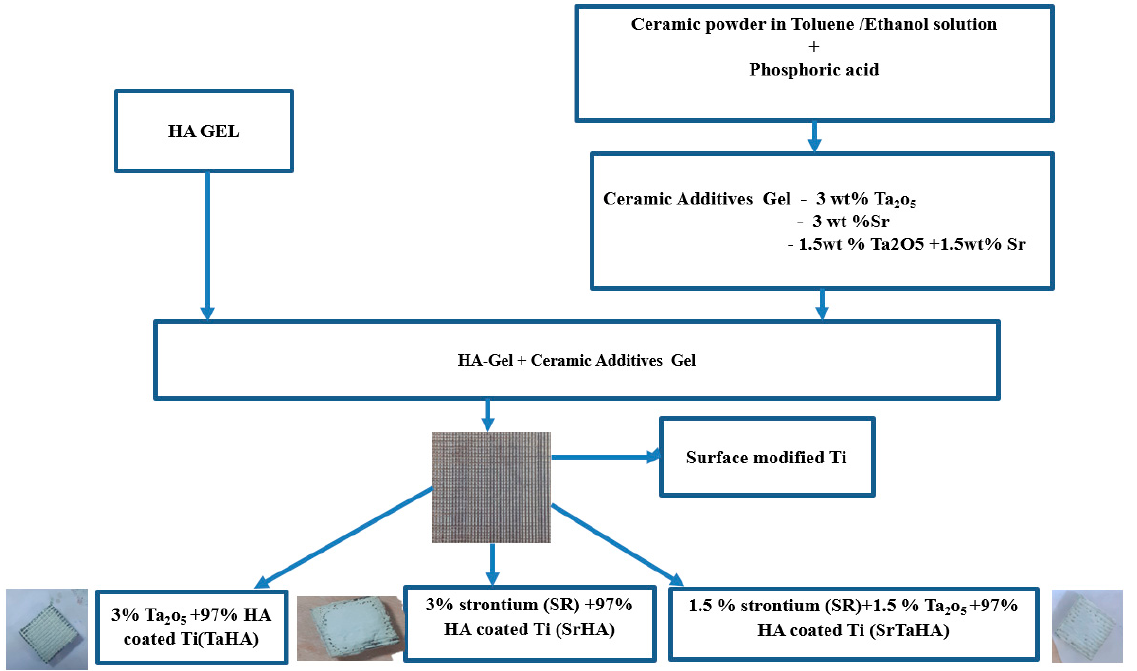
Figure 3. Schematic of HA with strontium and tantalum pentoxide coatings by sol-gel coating process.